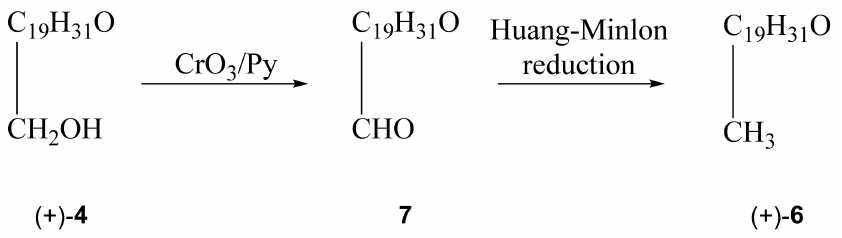
Scheme 2. Chemical work for the establishment of (+)-stemodinol ( 4 ) structure